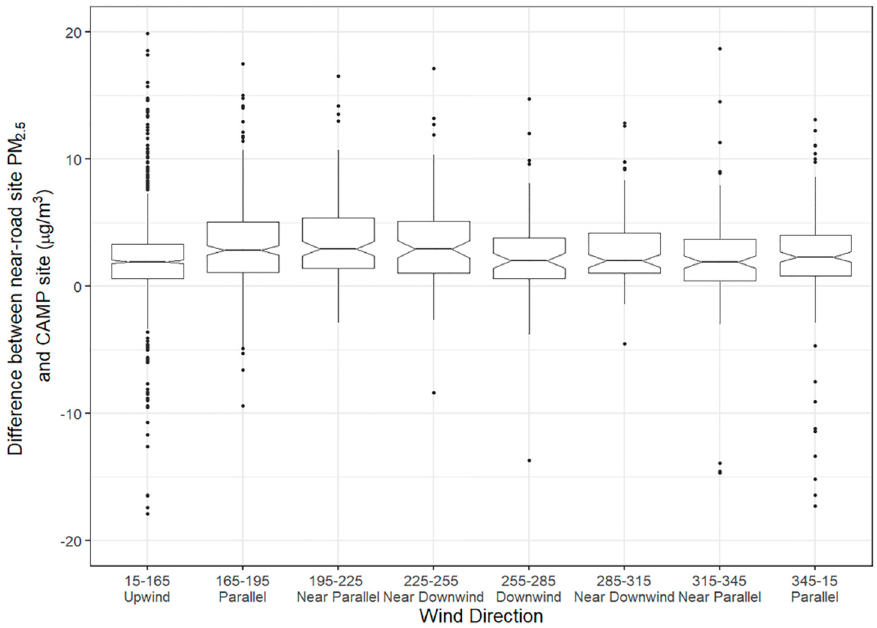
Figure 6. Notched box plot of the Denver hourly PM 2.5 increment (difference between near-road and CAMP site) by wind direction bin during 06:00 to 20:00 and when winds speeds are below 2 m/s. The notch shows the 95% confidence interval on the median and the boxes show the interquartile range (IQR); points beyond the IQR are within the notch or are plotted individually.